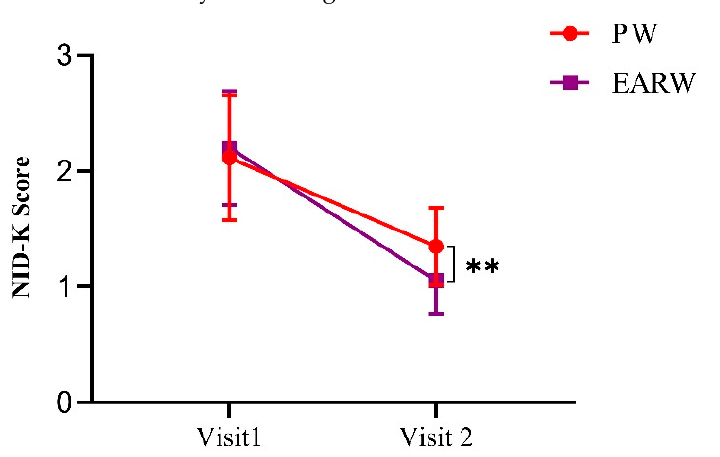
Figure 5C, the level of IFN- γ ( p = 0.73), IL-1 β ( p = 0.993) and IL-10 ( p = 0.102) showed a decreased tendency but not significant.